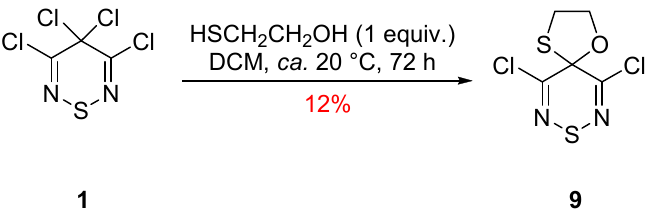
Figure 1. Comparison of 13 C NMR data to literature compounds, numbers in ppm rounded to the closer integer.